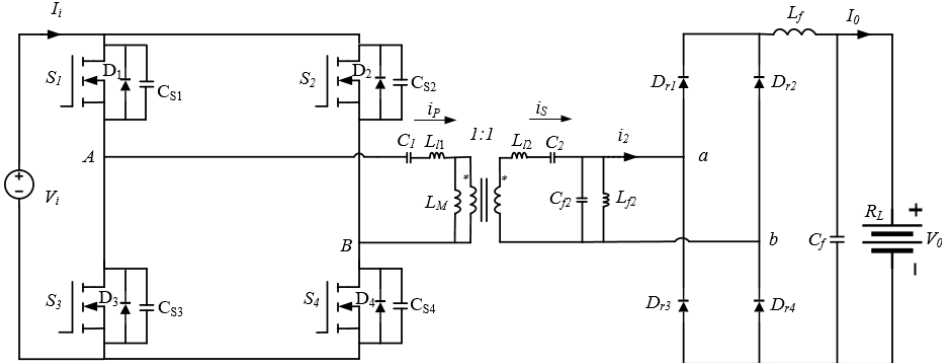
Figure 2. Proposed LC-LC 2 compensated resonant converter.